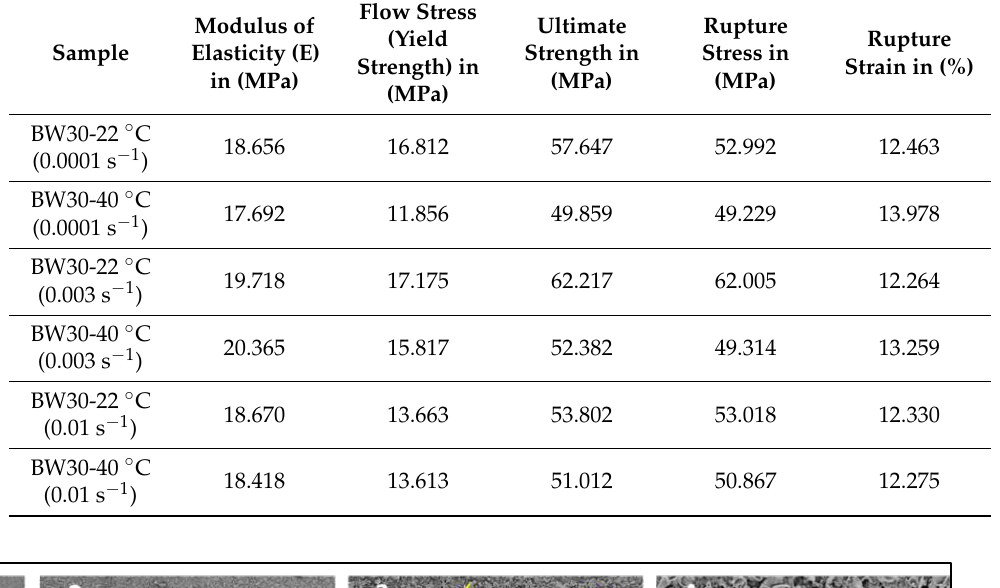
Table 4. Mechanical properties of BW30 membranes under wet (22 ◦ C and 40 ◦ C) conditions and different strain rates.